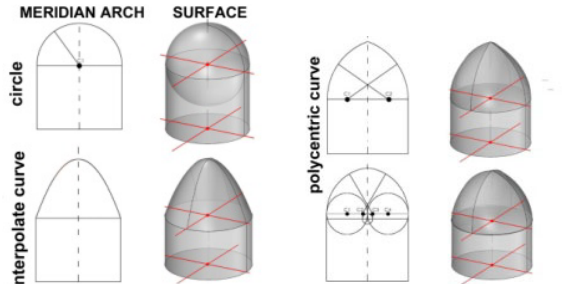
Figure 2. Circular domes: different geometry for domes of revolution